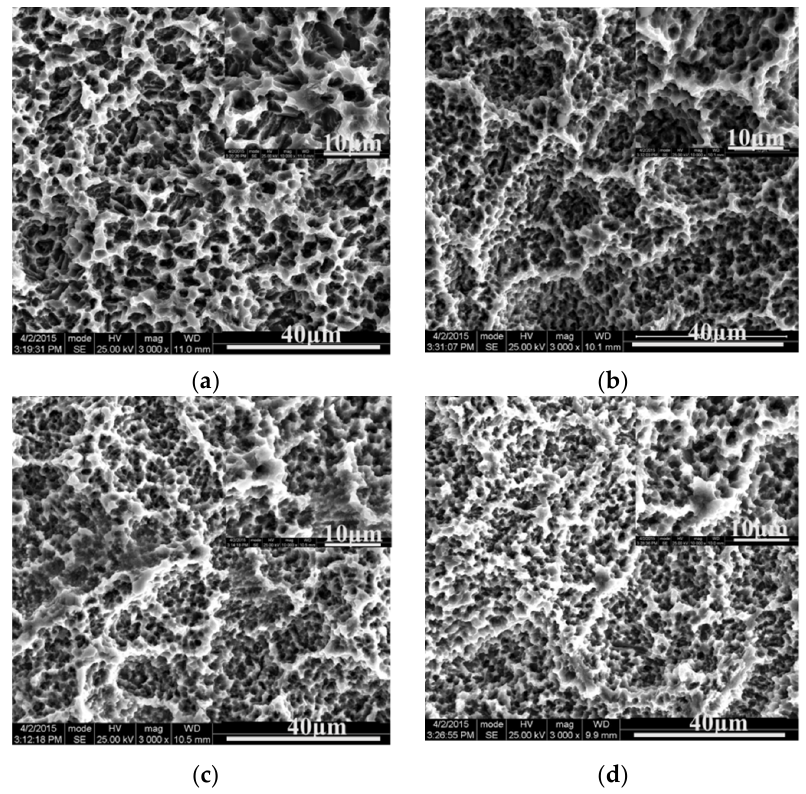
Figure 1. The surface morphologies of the four samples: ( a ) SLA sample; ( b ) SLA-PECVD sample; ( c ) SLA-PECVD/NaOH-10d sample; ( d ) SLA-PECVD/NaOH-200d sample. No morphological changes were found on the surfaces of the four samples.